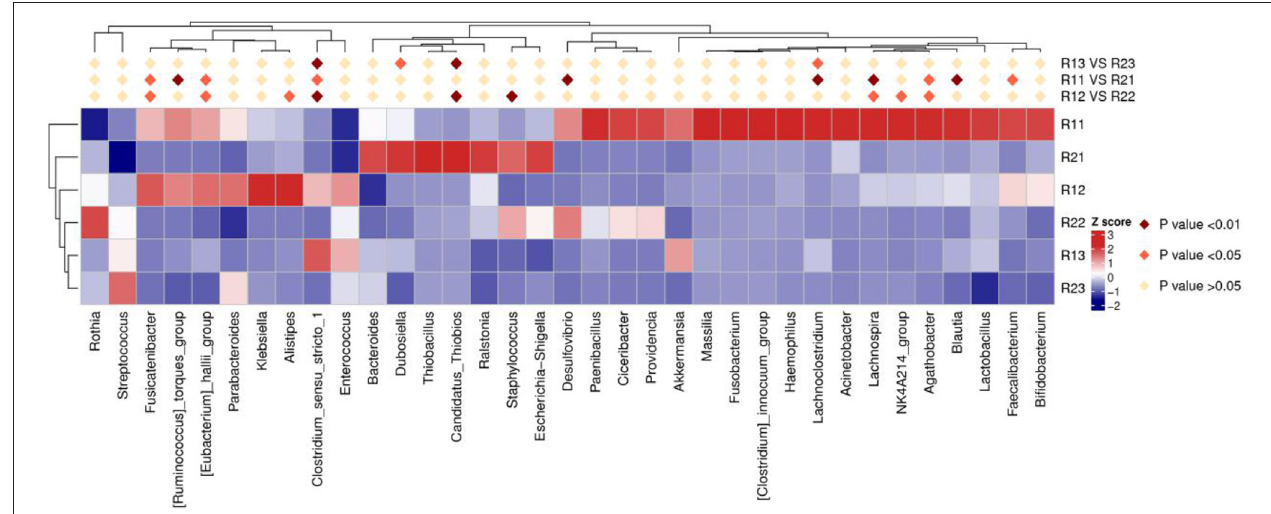
FIGURE 2 | Results of heatmap analysis of species with significant differences at the genus level. R11, gut flora of the study group on day 1; R21, gut flora of the control group on day 1; R12, gut flora of the study group on day 3; R22, gut flora of the control group on day 3; R13, gut flora of the study group on day 5; R23, gut flora of the control group on day